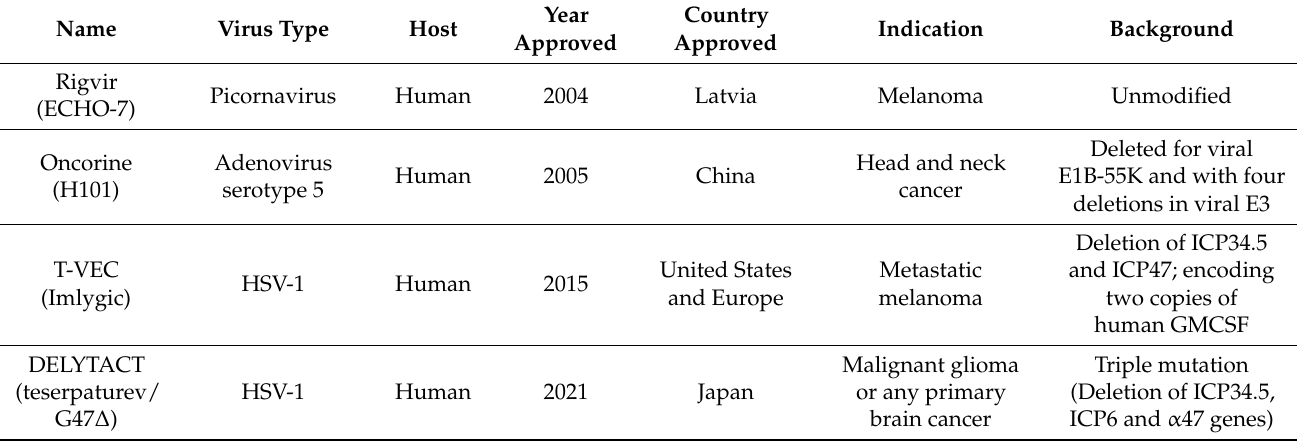
Table 1. List of approved oncolytic